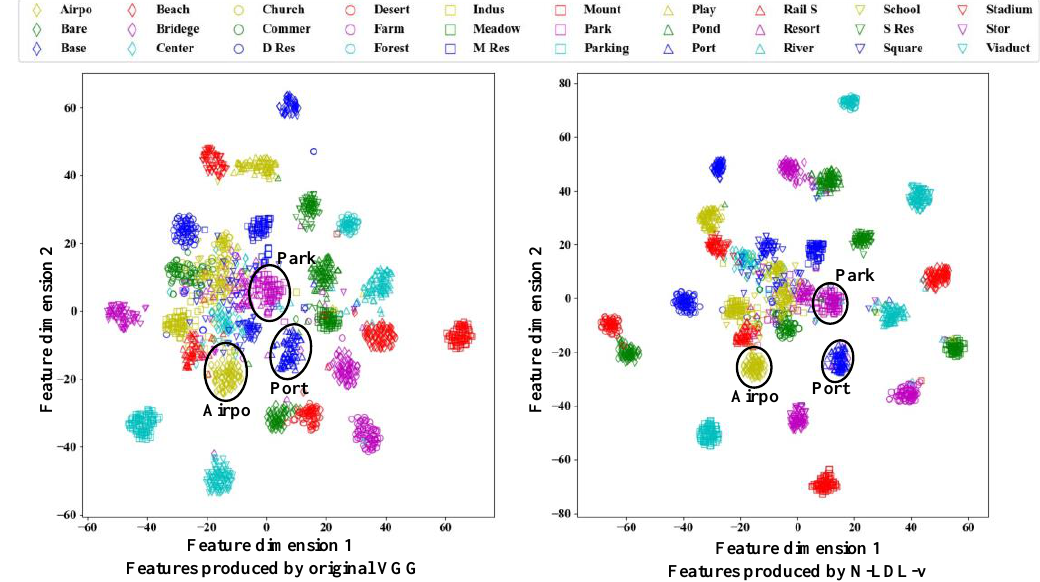
Figure 11. Two-dimensional representations of image features. The images come from the testing set of AID-0.2.